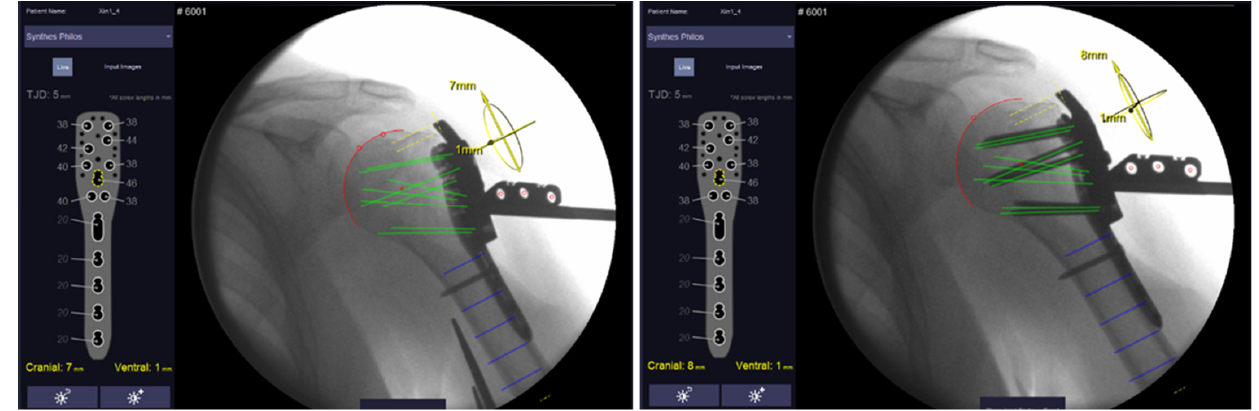
Figure 2. User interface of the Xin1 software for proximal humeral plating showing the semi ‐ auto ‐ matically selected humeral head (red circle) and the resulting virtual screw trajectories (green lines). All screw lengths are shown on the left side of the graphical user interface. Left image shows screw length determination after plate prepositioning and right after final screw insertion. Graphical user